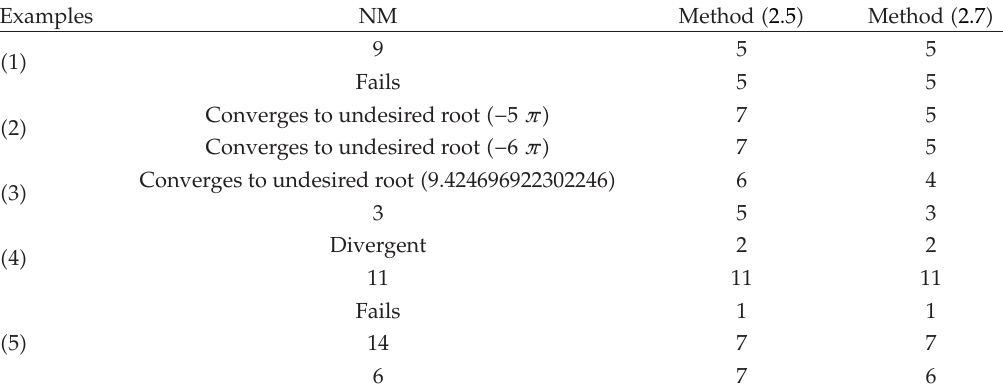
Table 2: Comparison table for nonlinear